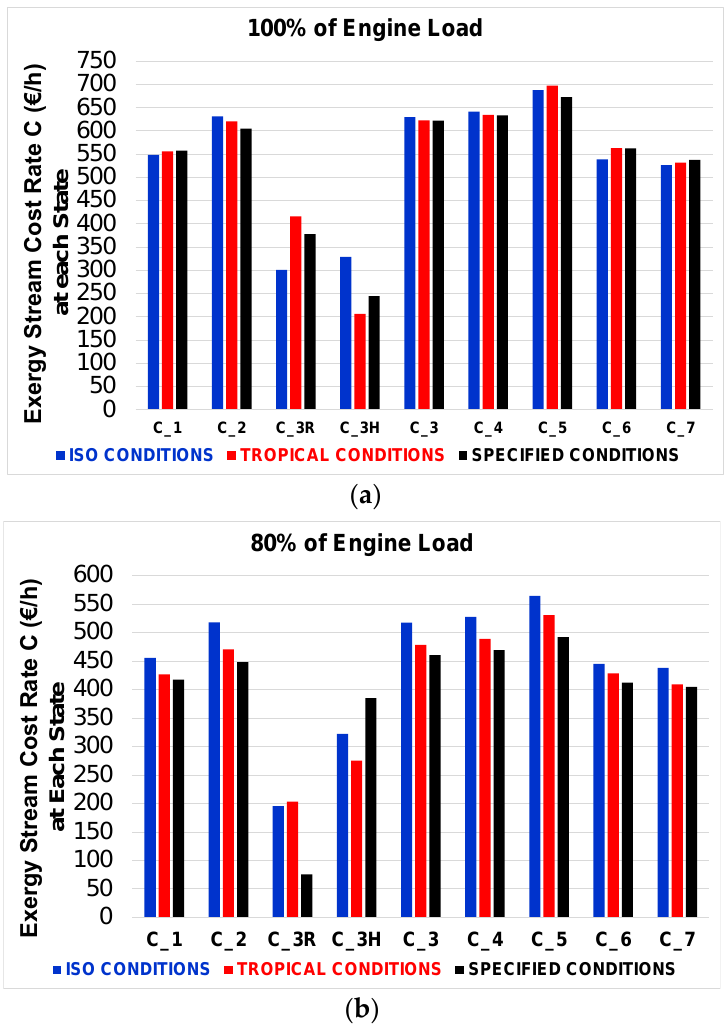
Figure 14. Variation of cost rate of exergy streams at each state at ( a ) full engine load and ( b ) 80% of full load for ISO, tropical, and specified conditions.